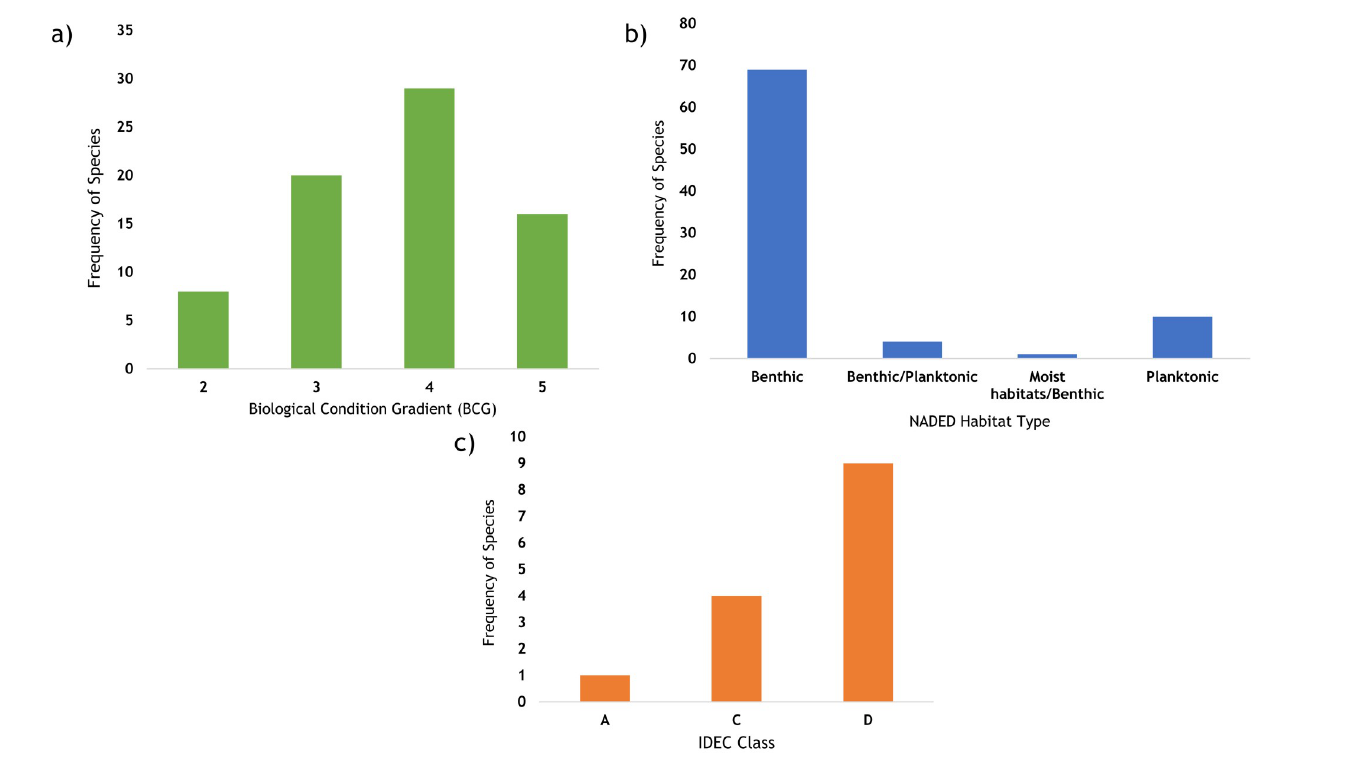
Fig 7. Frequency plots for diatom species identified in this study and present on the North American Diatom Database. a) Biological Condition Gradient (BCG) scores (number of diatom species = 73, 1 = specialist species, 2 = highly sensitive species, 3 = sensitive species, 4 = indiscriminate species and 5 = tolerant species); b) Habitat types (number of diatom species = 84); c) Eastern Canadian Diatom Index classes (number of diatom species = 14, A = reference condition, B = slightly altered, C = altered, D = severely altered conditions). https://doi.org/10.1371/journal.pone.0242143.g007 PLOS ONE | https://doi.org/10.1371/journal.pone.0242143 November18,